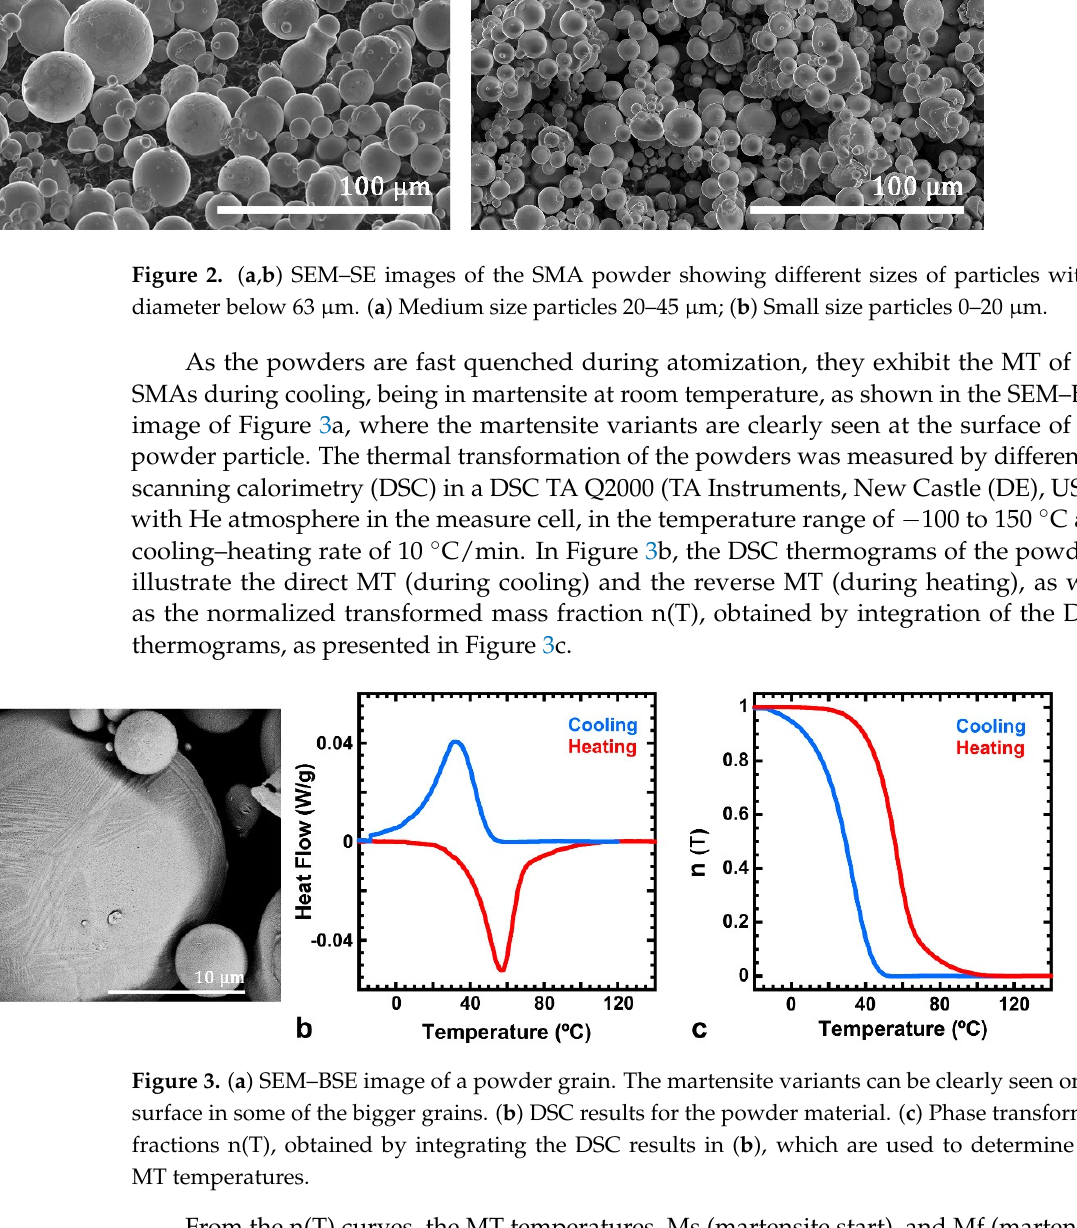
Figure 3. ( a ) SEM–BSE image of a powder grain. The martensite variants can be clearly seen on its surface in some of the bigger grains. ( b ) DSC results for the powder material. ( c ) Phase transformed fractions n(T), obtained by integrating the DSC results in ( b ), which are used to determine the MT temperatures.